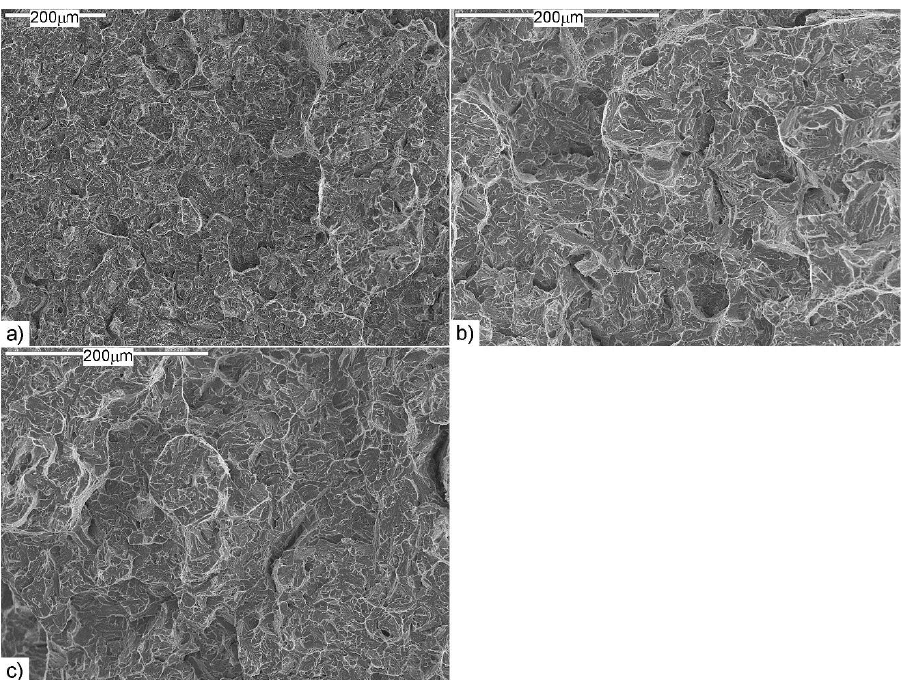
Figure 14. Fracture of the tested sample austenitized at 1000 °C: ( a ) the quasi-brittle central zone with visible ductile area; ( b ) the magnified central zone of the characteristic relief of “river patterns” with visible plastic ridges; ( c ) the central zone with visible “small column”, SEM.